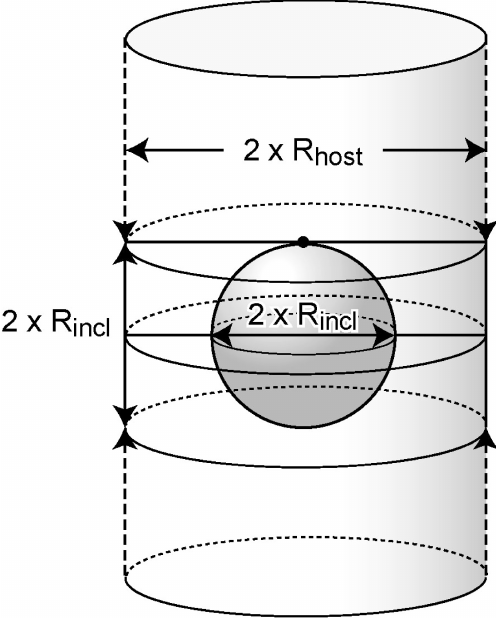
Figure 1. Simplified ablation geometry of a fluid inclusion (gas bubble) with radius R incl (µm) within the ablated host mineral (glass) idealized as a cylinder of radius R host